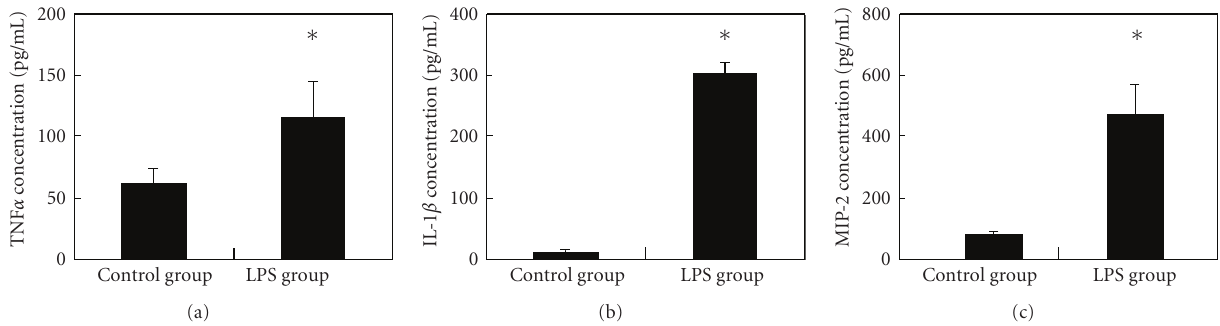
Figure 5: Concentration of TNF- α , MIP-2, and IL-1 β cytokines from BALF: (a) concentration of TNF- α , (b) concentration of MIP-2, (c) concentration of IL-1 β